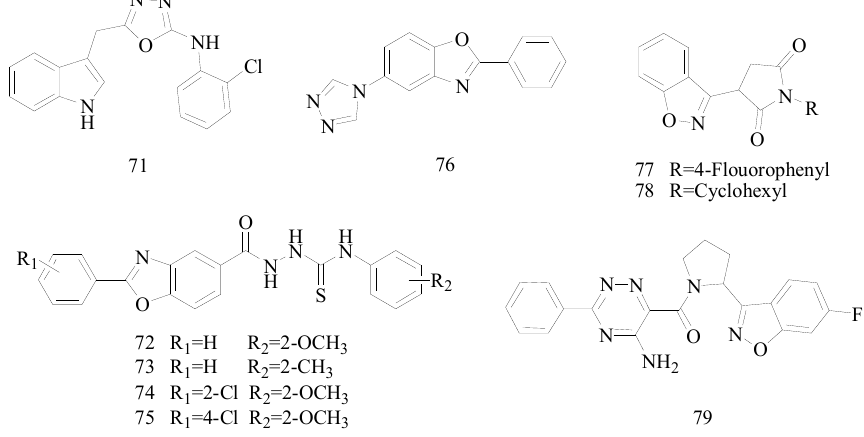
Figure 3. Structures of compounds 71 – 79 .